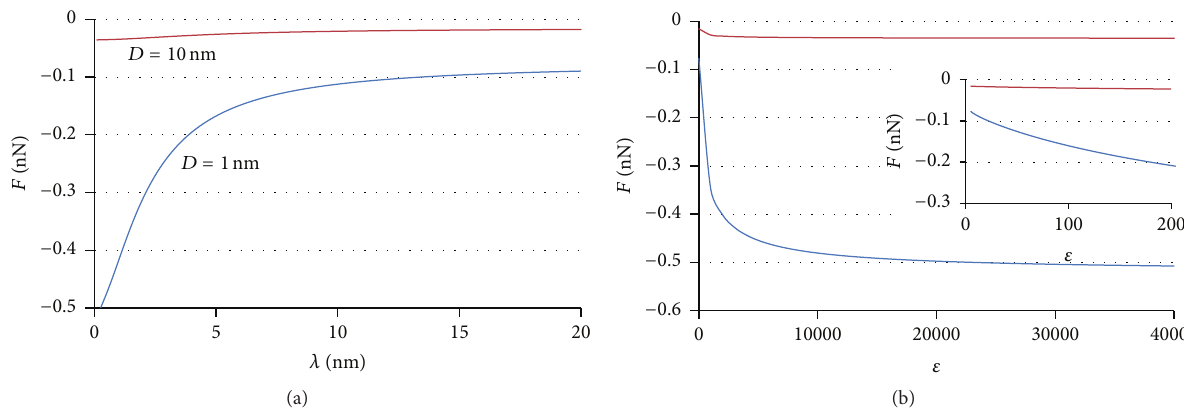
Figure 3: (a) Vertical electrostatic force as a function of the screening length. (b) Vertical electrostatic force as a function of the thin film dielectric constant. Inset shows the values of the force for smaller dielectric constants. In both figures, the force has been calculated for 𝐷 = 1 nm and 𝐷 = 10 nm, and 𝑅 = 20 nm, ℎ = 1 nm, 𝜀